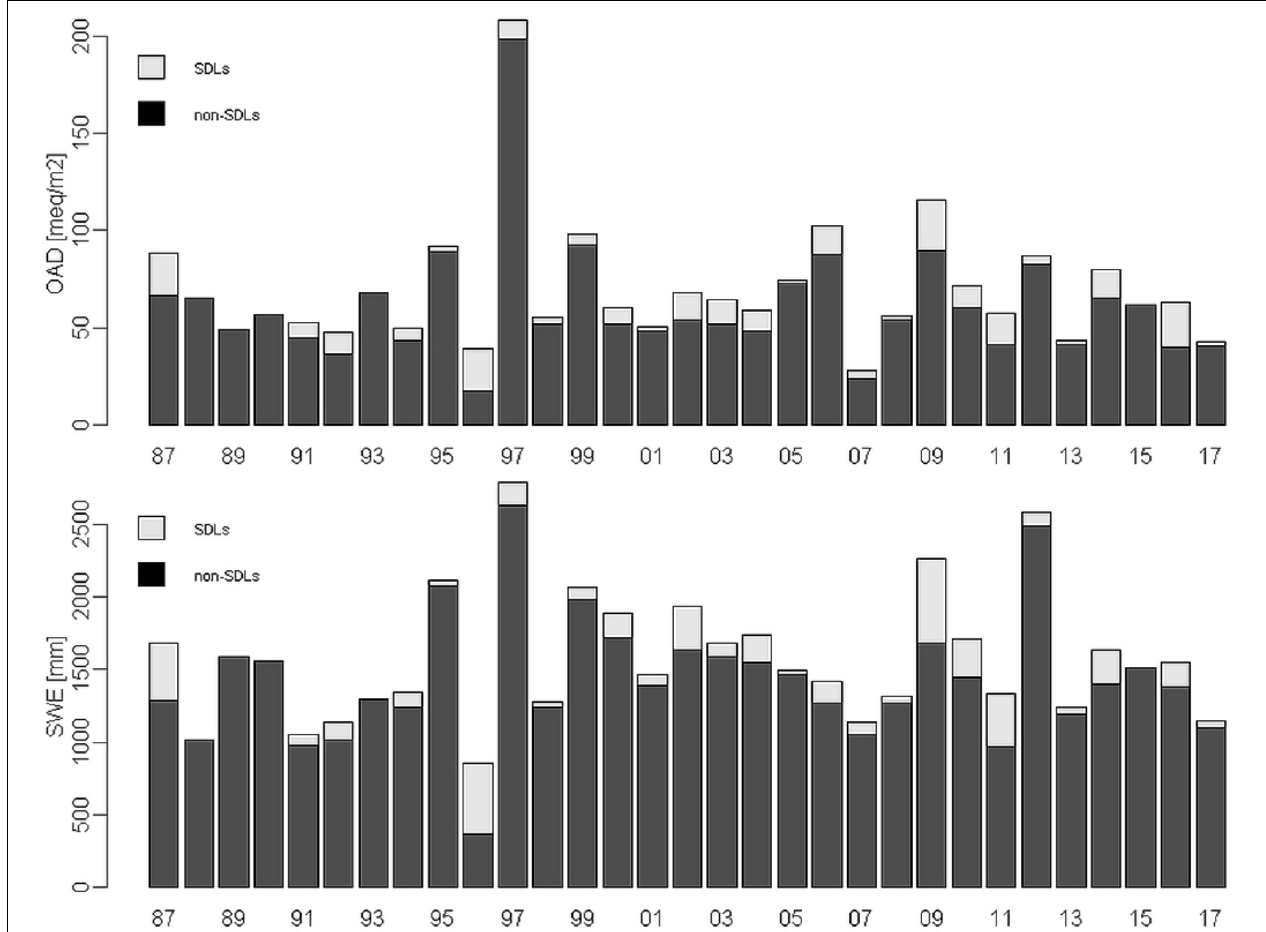
FIGURE 4 | Interannual variability of the overall annual deposition load including all ions (OAD) in meq/m 2 as well as of the snow water equivalent (SWE) in mm separated in the contribution of Saharan dust layers (SDLs) in gray and non-SDLs in